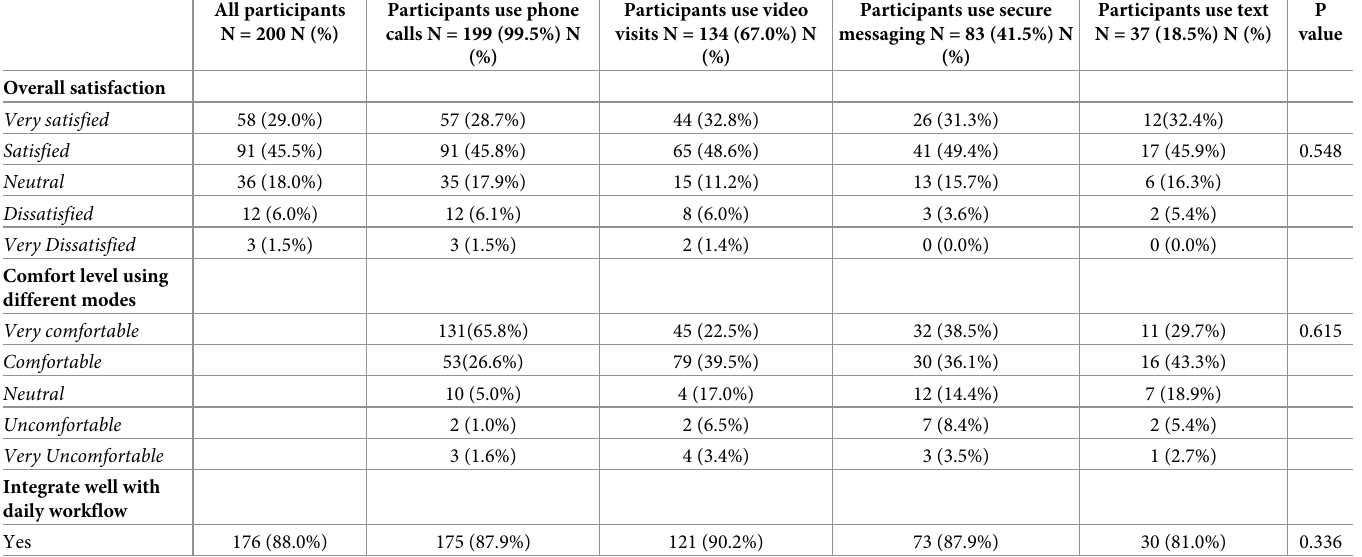
Table 3. Satisfaction and comfort level with different modalities of virtual